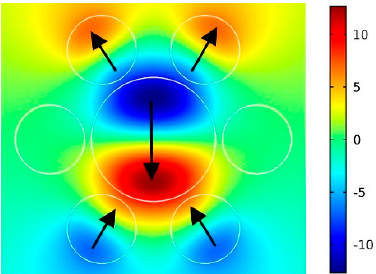
Figure 4. The E distribution at Fano resonance when the chemical potential of central nanodisk is 0.6 eV.